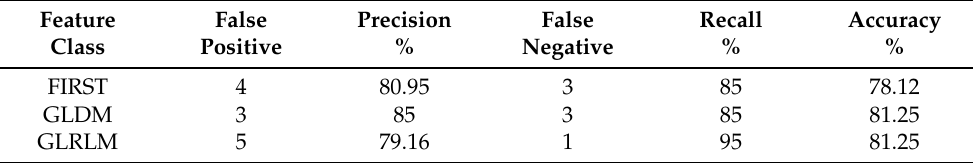
Table 5. Step 2: Results of the comparison between general lung disease and COVID-19 patients.